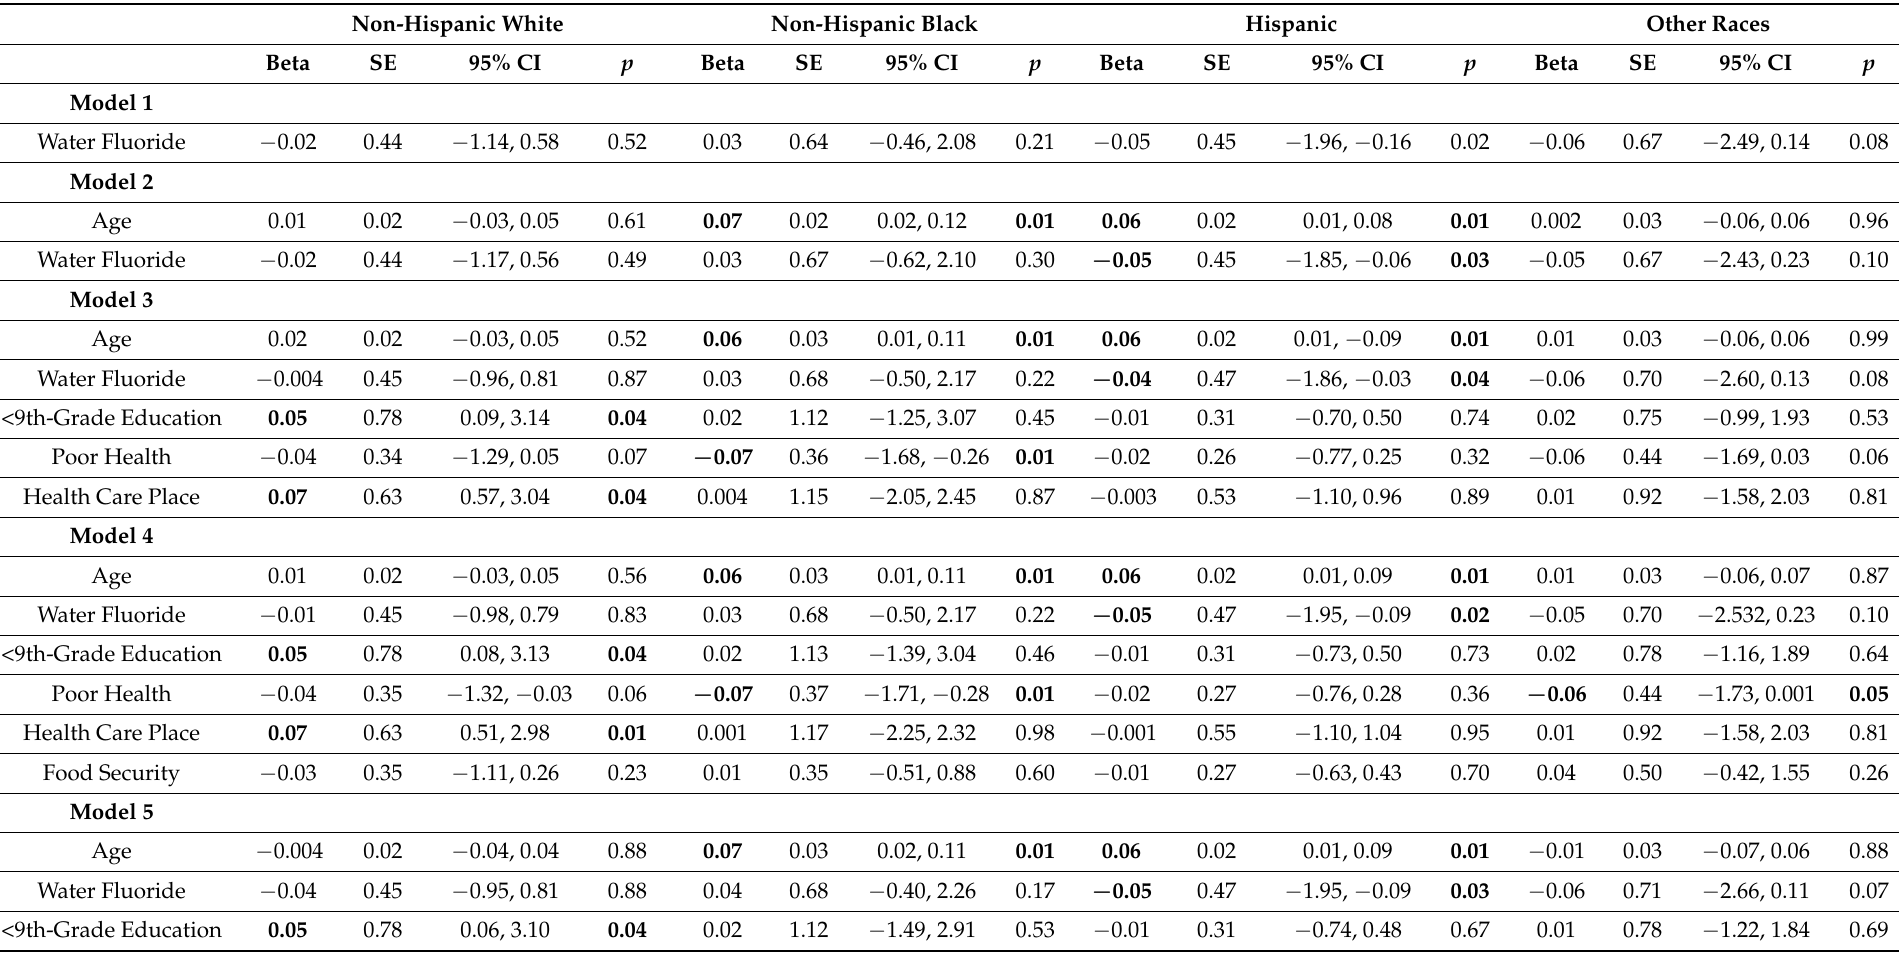
Table 2. Associations between socio-demographic, smoking, and water fluoridation levels and birth weight: data from the National Health and Nutrition Examination Survey (NHANES)